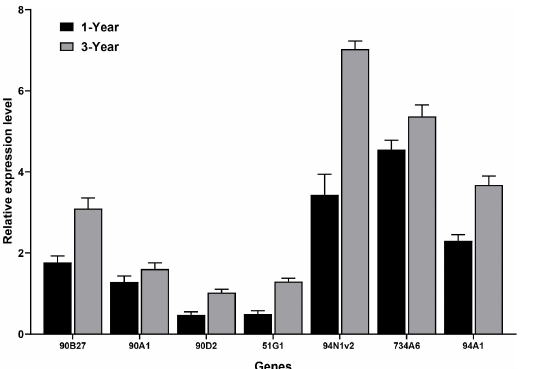
Figure 3. The relative expression levels of candidate CYPs in F. cirrhosa bulbs of 1 year of age and 3 years of age. The error bars indicate ± SDs ( n = 3). Genes 2023 , 14 , 219